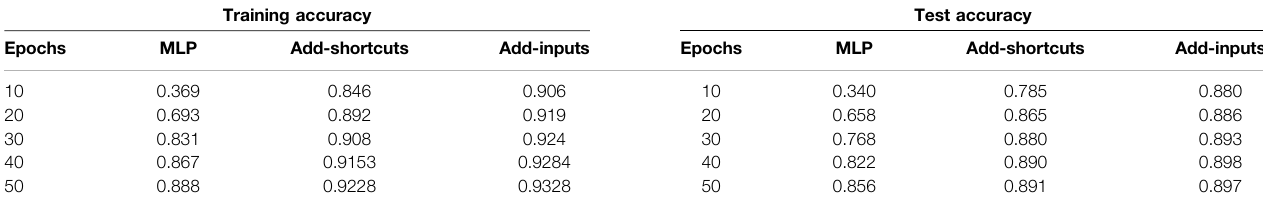
TABLE 1 | Fashion MNIST training and test accuracy average of three runs comparing multilayer perceptron (MPL) to our proposed architectures.